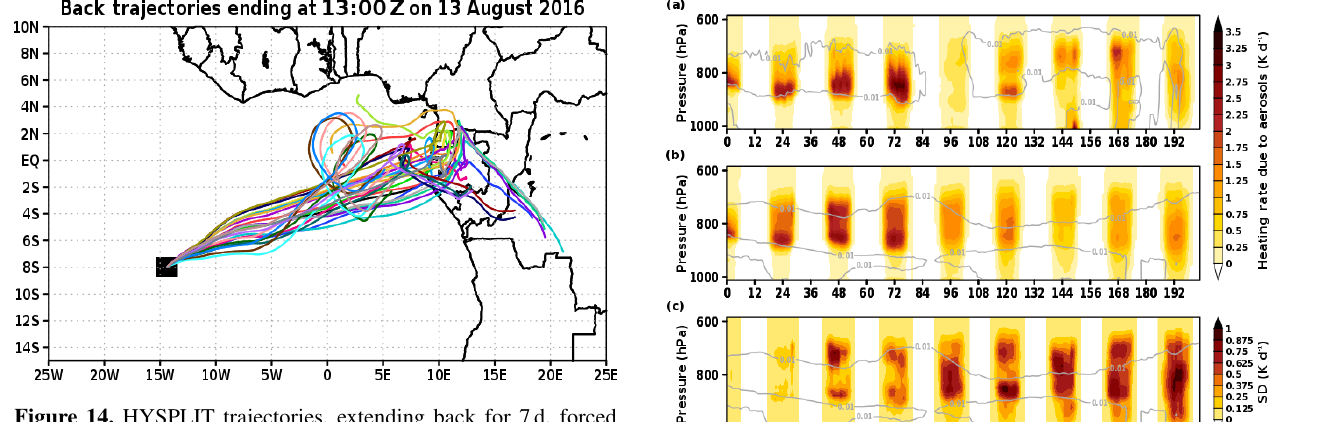
Figure 14. HYSPLIT trajectories, extending back for 7d, forced with meteorology from the 27 ensembles of the GDAS, originating at 2km above Ascension Island at 13:00Z on 13 August 2016.